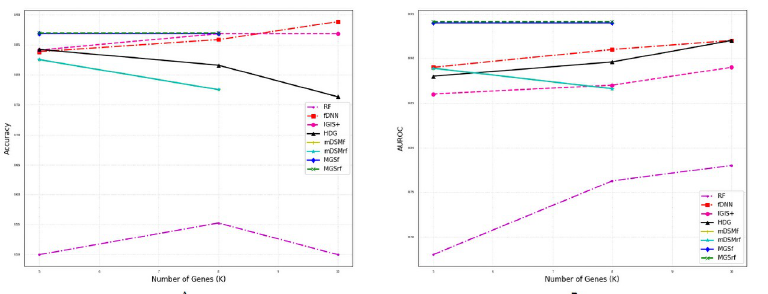
Fig 2. Performance comparison using different number of selected genes for the GDS5306 dataset. (A) Accuracy. (B) AUROC.